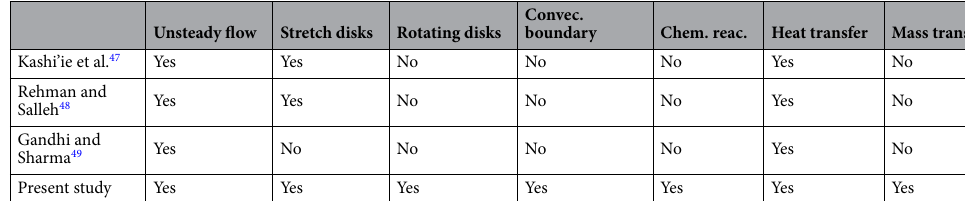
Convec. boundary